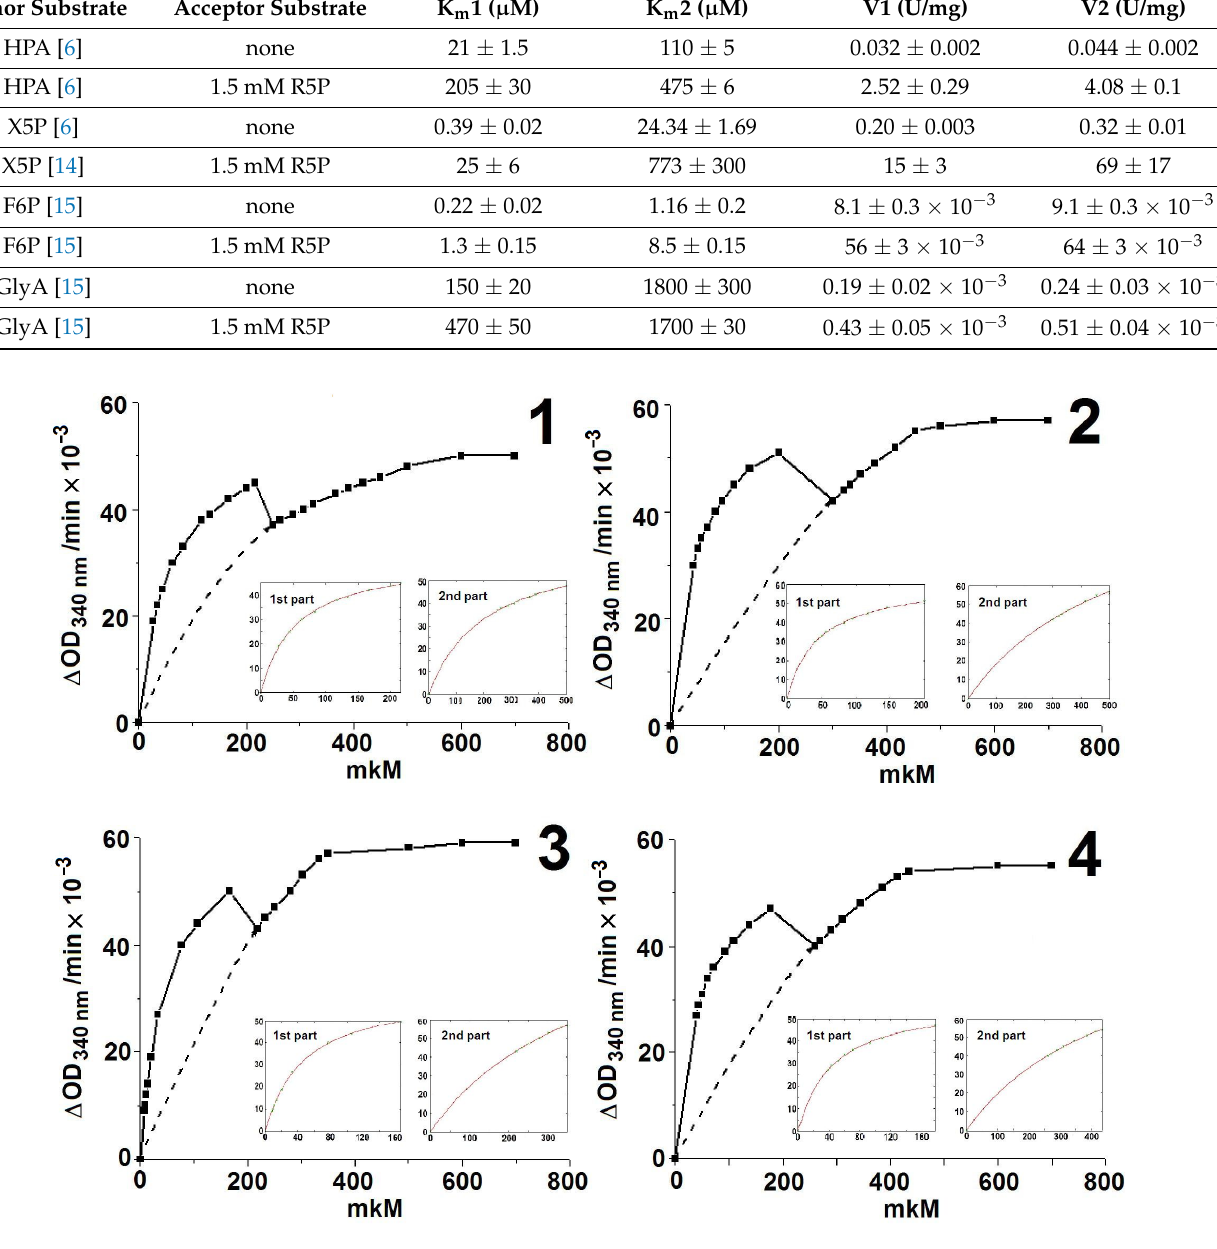
Figure 3. Dependence of holoTK activity in the two-substrate reaction on concentration of X5P. All curves contain data from one experiment of the same type. Inserts—fitting both parts of the curves.